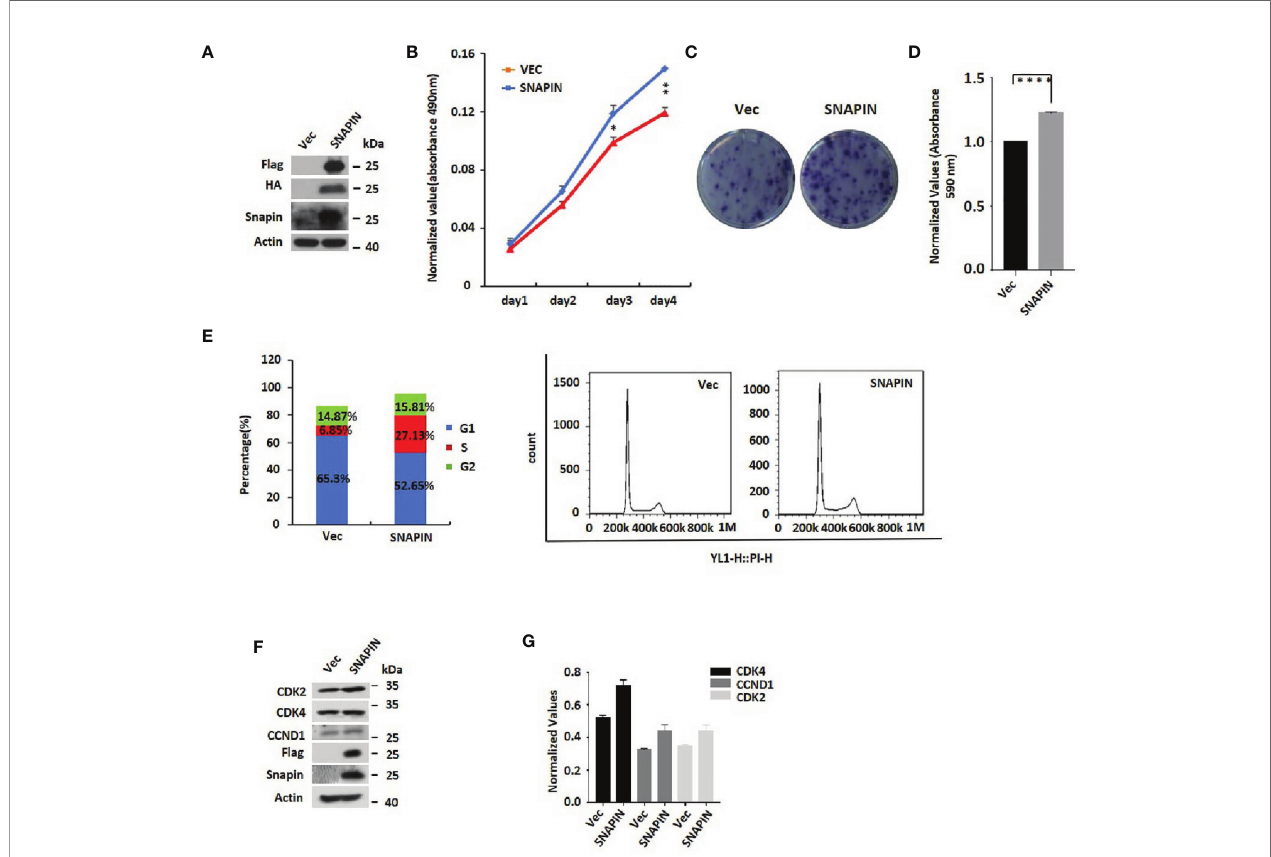
FIGURE 4 | SNAPIN overexpression induces proliferation of b cells. Min6 cells were transduced with non-speci fi c and SNAPIN speci fi c Sequences. (A) Min6 cells were treated with lentivirus. A signi fi cant increase in SNAPIN protein by Western blot analysis. (B) MTS analysis illustrated the proliferation of Min6 cells induced after SNAPIN overexpression. (C, D) Clone formation showed that SNAPIN overexpression induced the proliferation of b cells. (E) The cells were stained with PI staining. Adherent cells were collected, and cell cycle analysis was done by fl ow cytometry. SNAPIN overexpression increased the population of cells in the S phase. (F) The protein expression levels of CyclinD1, CDK2 and CDK4 were checked by Western blot with indicated antibodies. (G) Normalized histograms of snapin protein against actin by using imaging software. *P < 0.05, **P < 0.01, ****P <